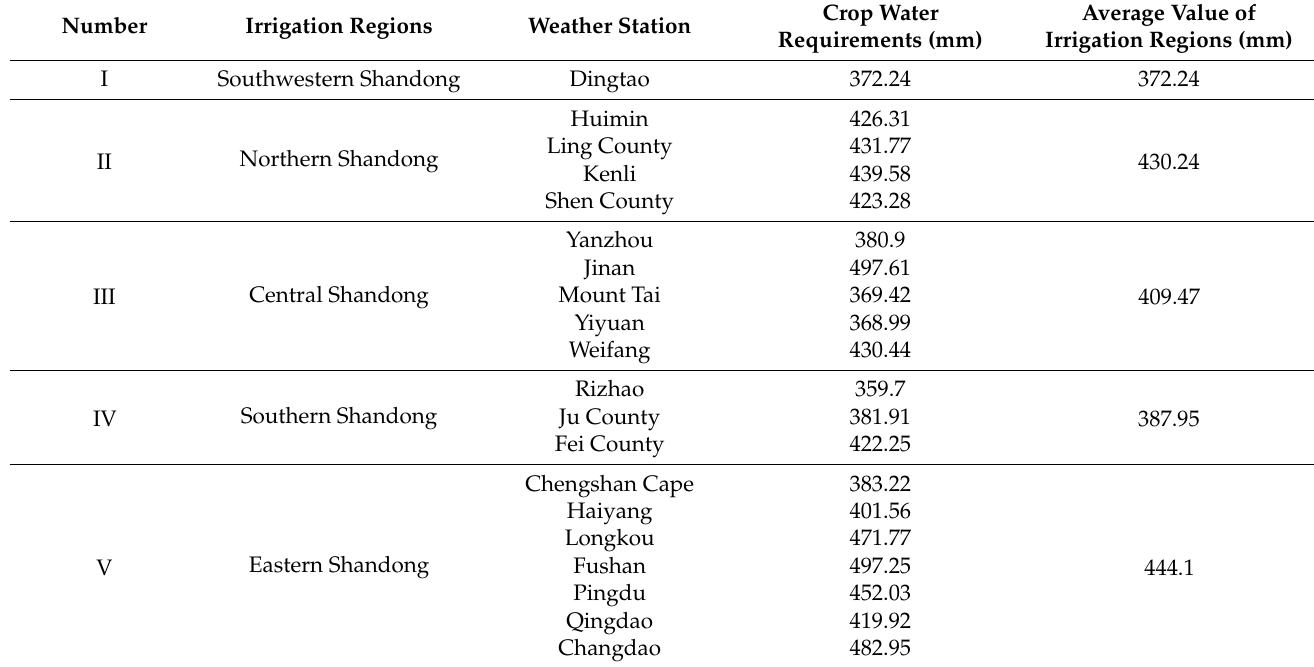
Table 2. The multi-year average water requirements of winter wheat crops from 1968 to